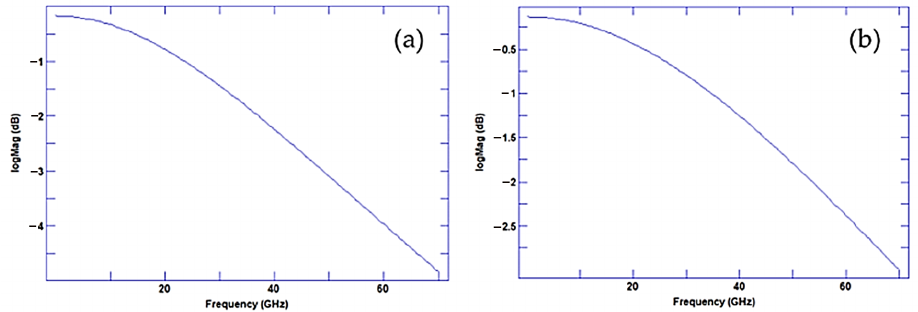
Figure 6. Simulated S21 measurements extracted from experimental S11 measurements of EAM devices with length 50 µ m and width 25 µ m with impedance ( a ) 50 Ω ( b ) 25 Ω